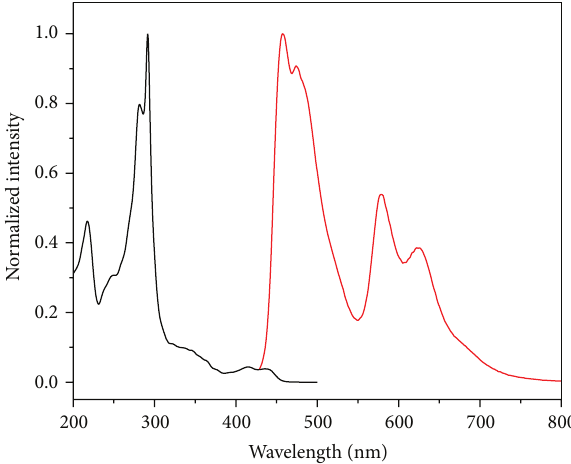
Figure 3: Normalized absorption (black line) and emission (red line) spectra of 1 in cyclohexane.